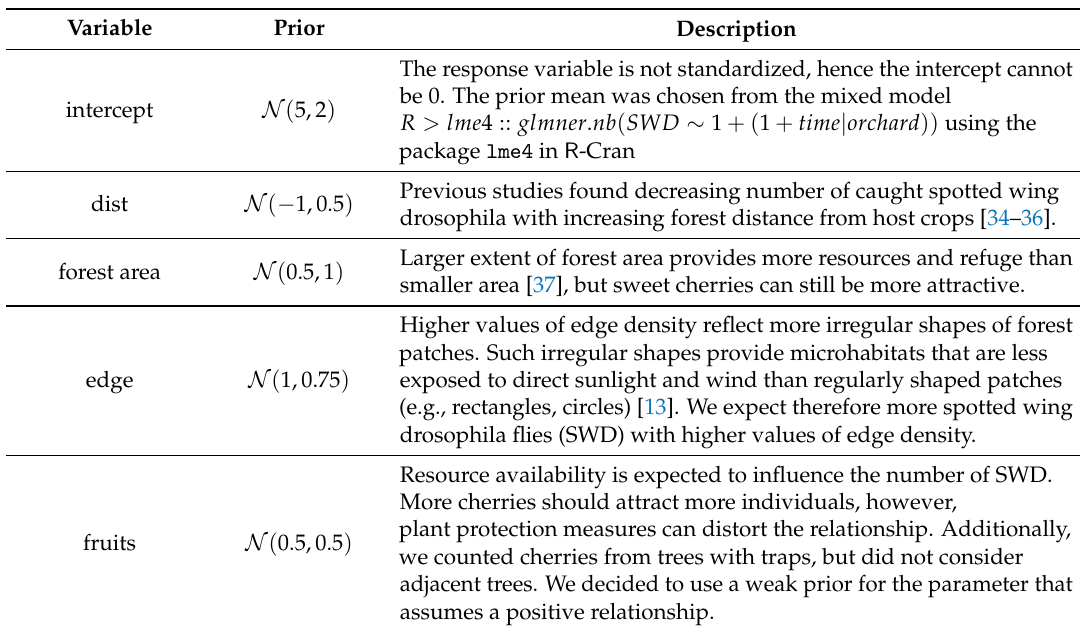
Table A1. Priors of the Bayesian mixed model for parameters and their explanations. For all other parameters, the default priors of the function brm in the R package brms version 2.3.0 were used. Please note that all explanatory variables were standardized to mean µ = 0 and standard deviation σ = 1 before the analysis. N ( µ , σ 2 ) = normal distribution with mean µ and variance σ 2 , C ( a , b ) = Half-cauchy distribution with location a and scale b , G ( k , θ ) = Gamma distribution with shape parameter k and scale parameter θ , LJK ( ν ) = Lendowski-Kurowicka-Joe prior with parameter ν for correlation